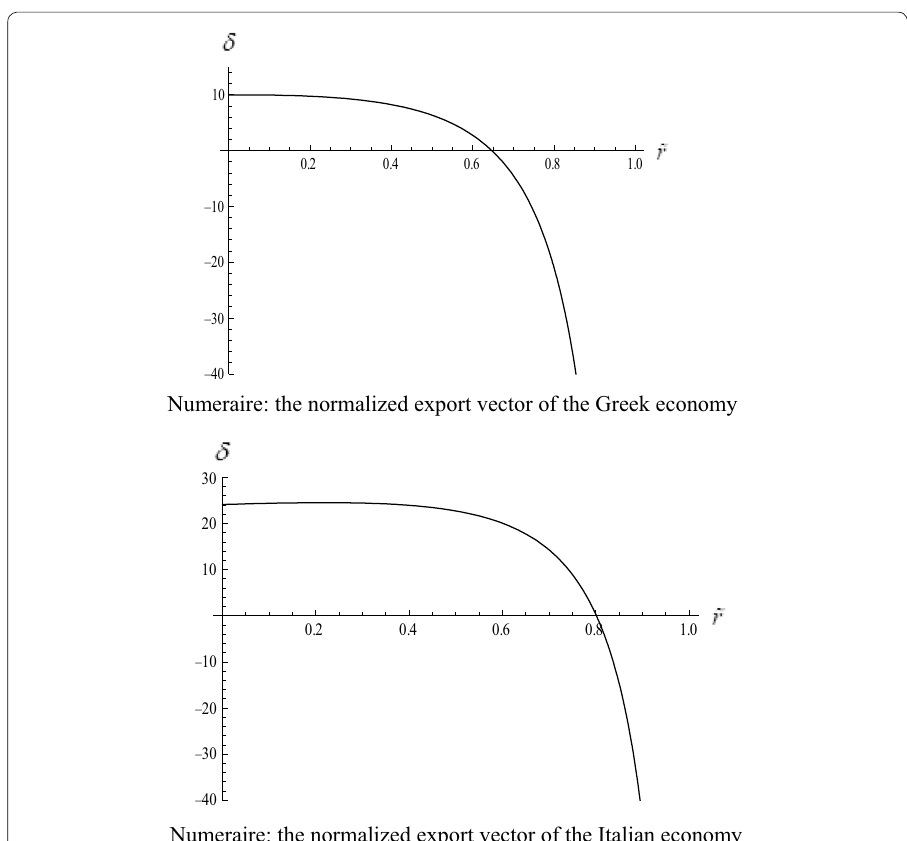
Fig. 6 The difference between the denominator components of the wage-profit rates trade-off as a function of the profit rate; Greek and Italian